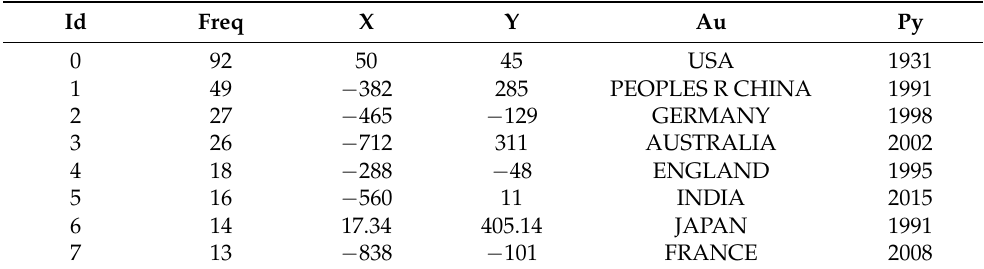
Table 1. Ranking of WOS Cooperative Citations.